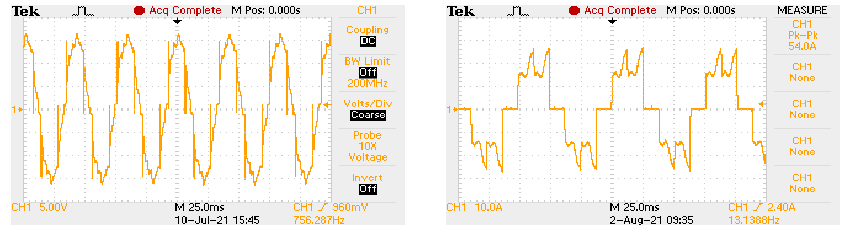
Figure 8. Sample research recording of the phase-to-phase voltage waveform of the tested motor ( left oscillogram) and the current of one motor phase ( right oscillogram).